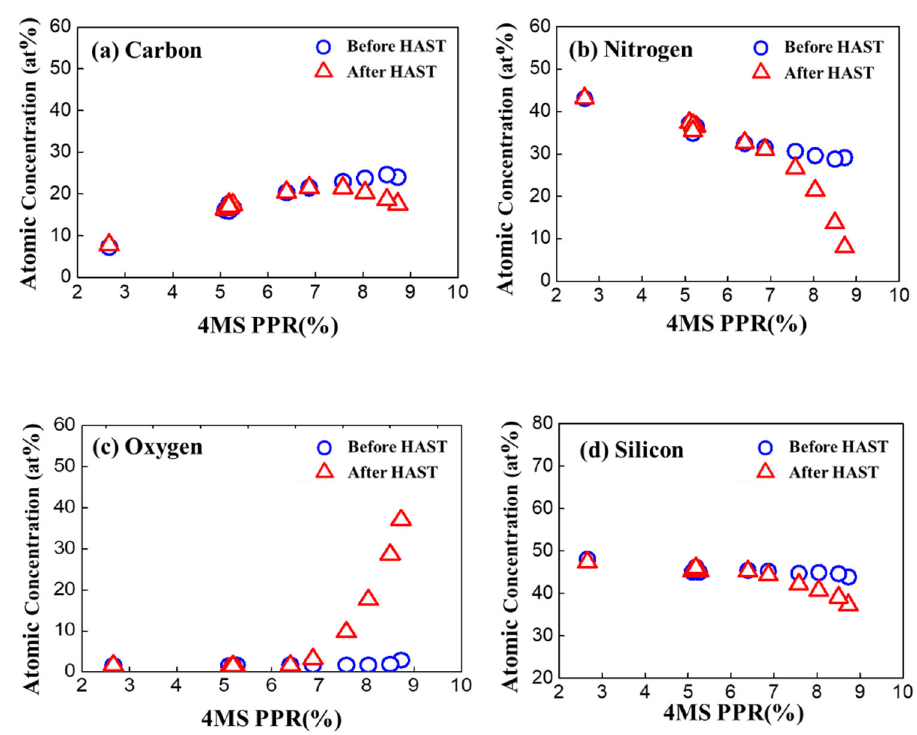
Figure 10. Concentration before and after the HAST according to the 4MS PPS for ( a ) carbon, ( b ) nitrogen, ( c ) oxygen, and ( d ) silicon.